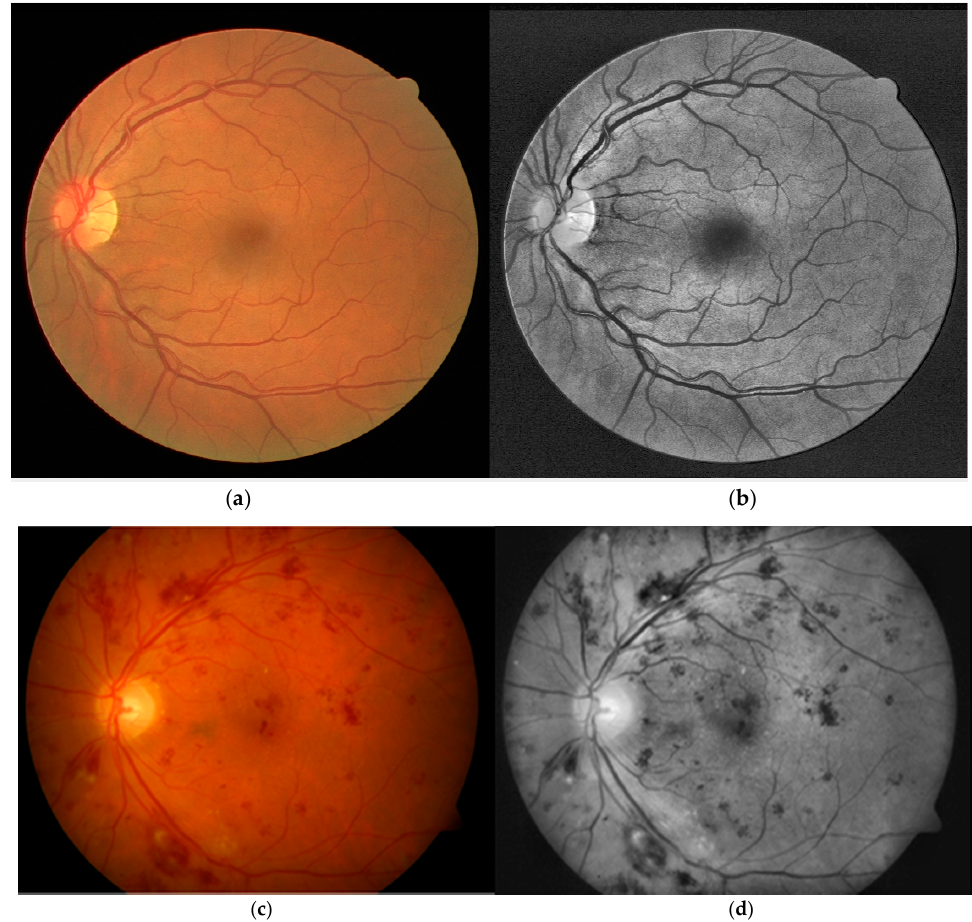
Figure 4. ( a ) Original healthy retinal image from the DRIVE dataset; ( b ) Enhancement of image ( a ) using CLAHE; ( c ) Original diseased retinal image from the DIARETDB0 dataset; ( d ) Enhancement of image ( c ) using CLAHE.